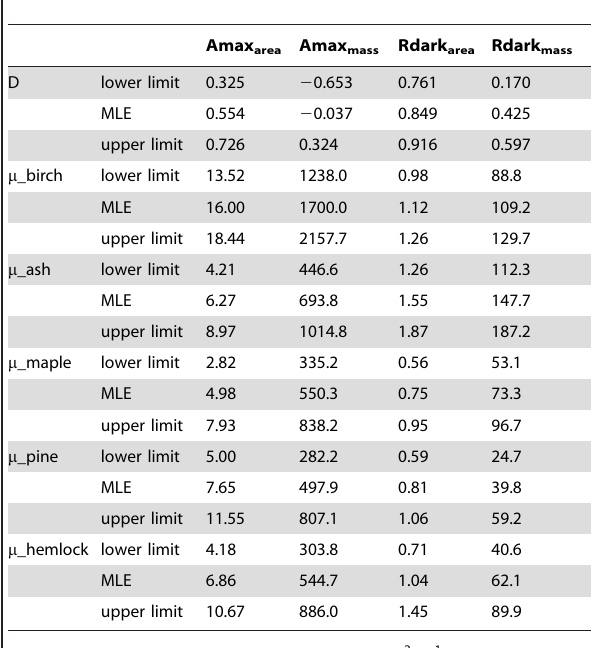
Table 2. Maximum likelihood estimates (MLE) and 95% confidence limits for parameters in Model